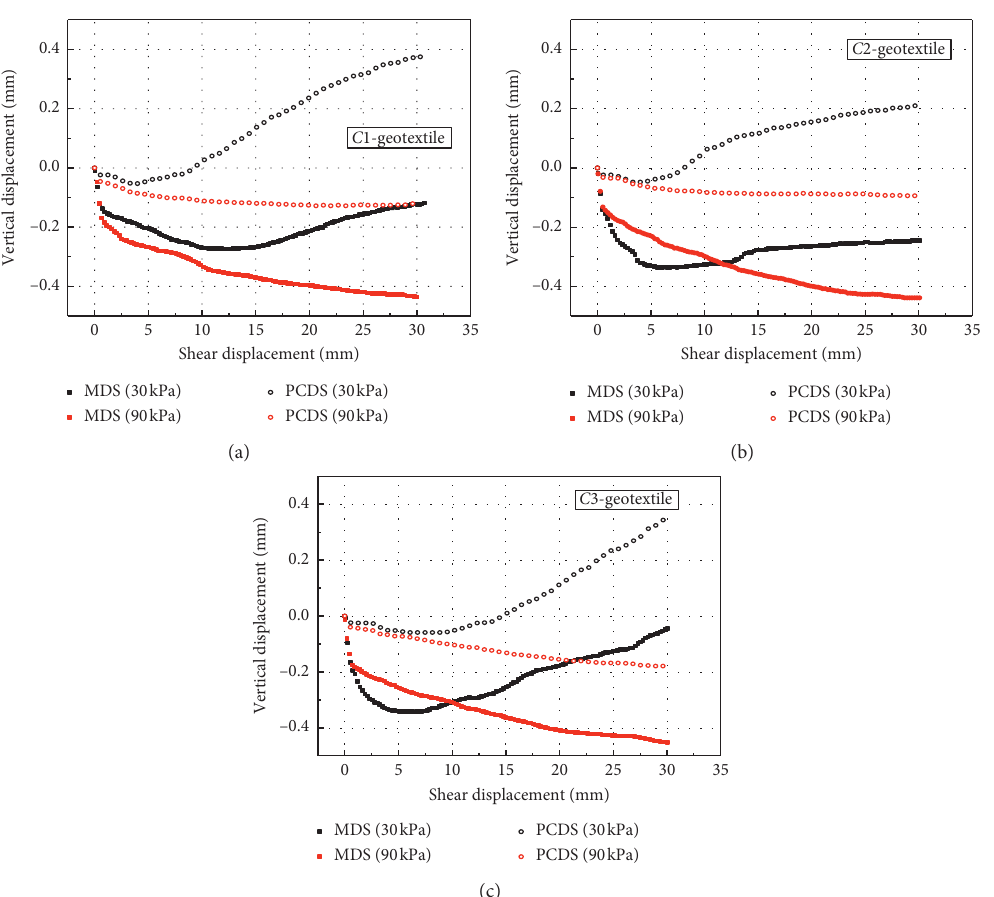
Figure 9: Comparison of the shear displacement-vertical displacement curves for the MDS and PCDS tests.